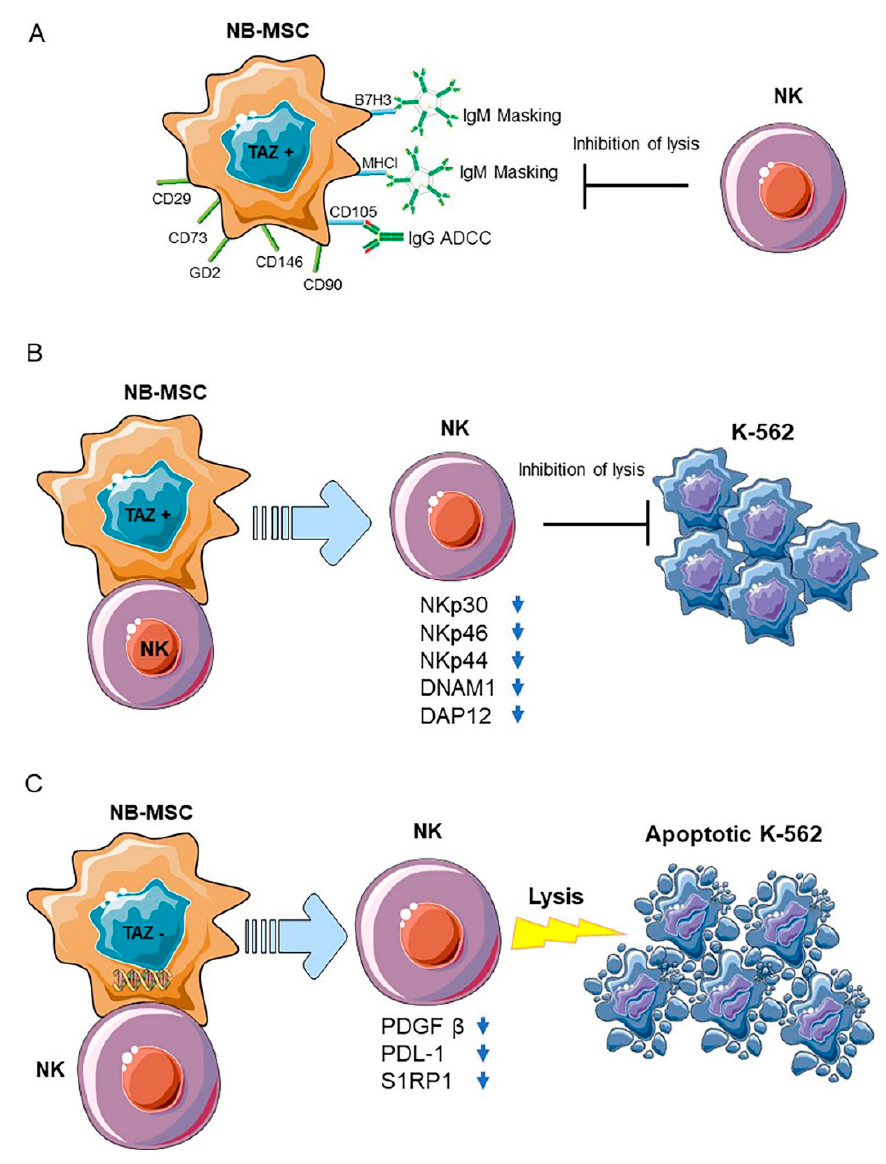
Figure 1. ( A ) NB-MSCs (CD105+/CD90+/CD73+/CD29+/CD146+/GD2+/TAZ+) exhibited mul- tifactorial resistance to NK-mediated lysis. Activated NKs are unable to lyse NB-MSCs, even after B7-H3 or MHC-I masking or through ADCC mediated by anti-CD105 IgG and anti GD2 IgG. ( B ) NB- MSCs in contact with freshly isolated NK cells for 4 days induce a decreased capacity for killing K-562 cells in the latter through cell–cell contact-mediated mechanisms. This behavior is associated with a sharp decreased expression of natural cytotoxicity receptors (NCRs): NKp30, NKp46, and NKp44, of the adhesion and activating molecule DNAM1 and of the adaptor protein DAP12. ( C ) The latter property was partially controlled by TAZ, since its silencing in NB-MSC cells rescued freshly isolated NK-cell cytotoxic activity on the K-562 cells after 4 days of the coculturing of NB- MSC with NK cells efficiently. This is related to a reduction in the expression of platelet derived growth factor β (PDGF β ), programmed death-ligand 1 (PDL-1), and sphingosine-1-phosphate receptor (S1PR1).